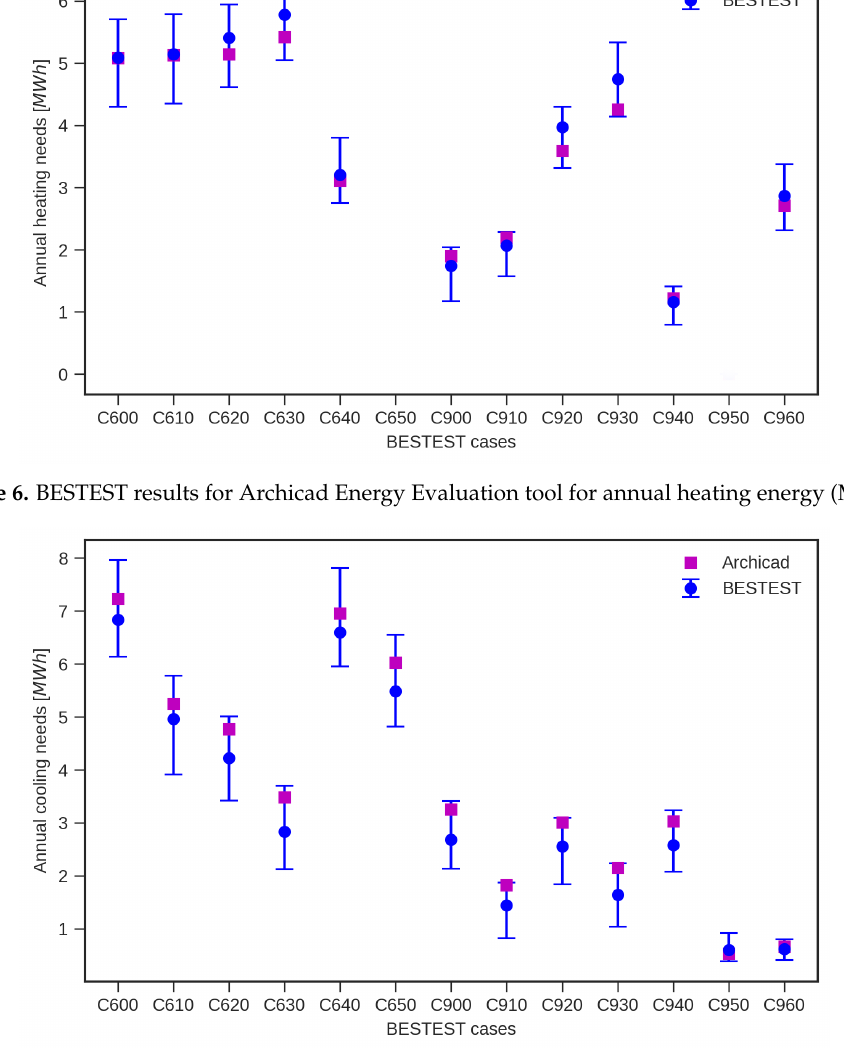
Figure 7. BESTEST results for Archicad Energy Evaluation tool for annual cooling energy